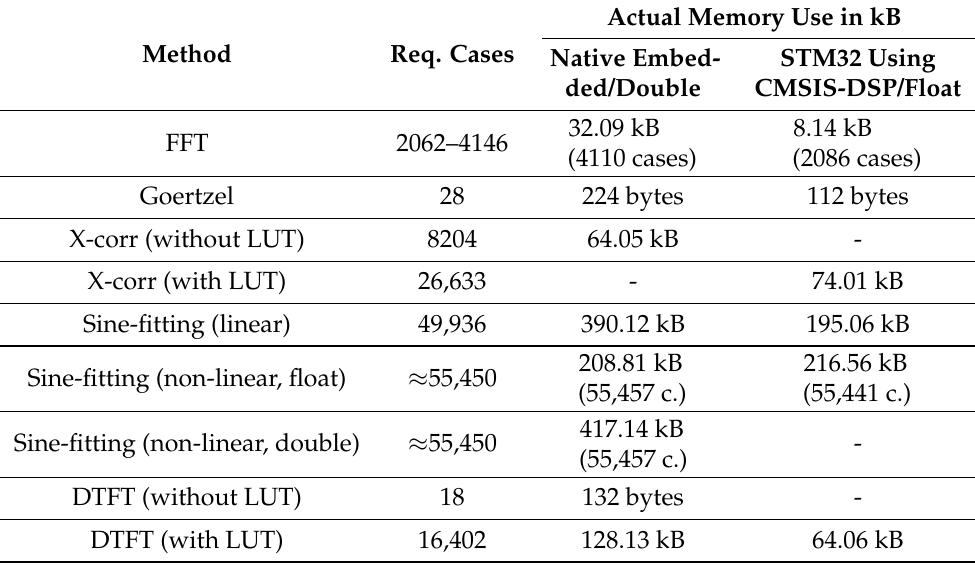
Table 9. Comparison of the memory consumption of the AC signal analysis methods in the native C and vectorized hardware-accelerated implementation.